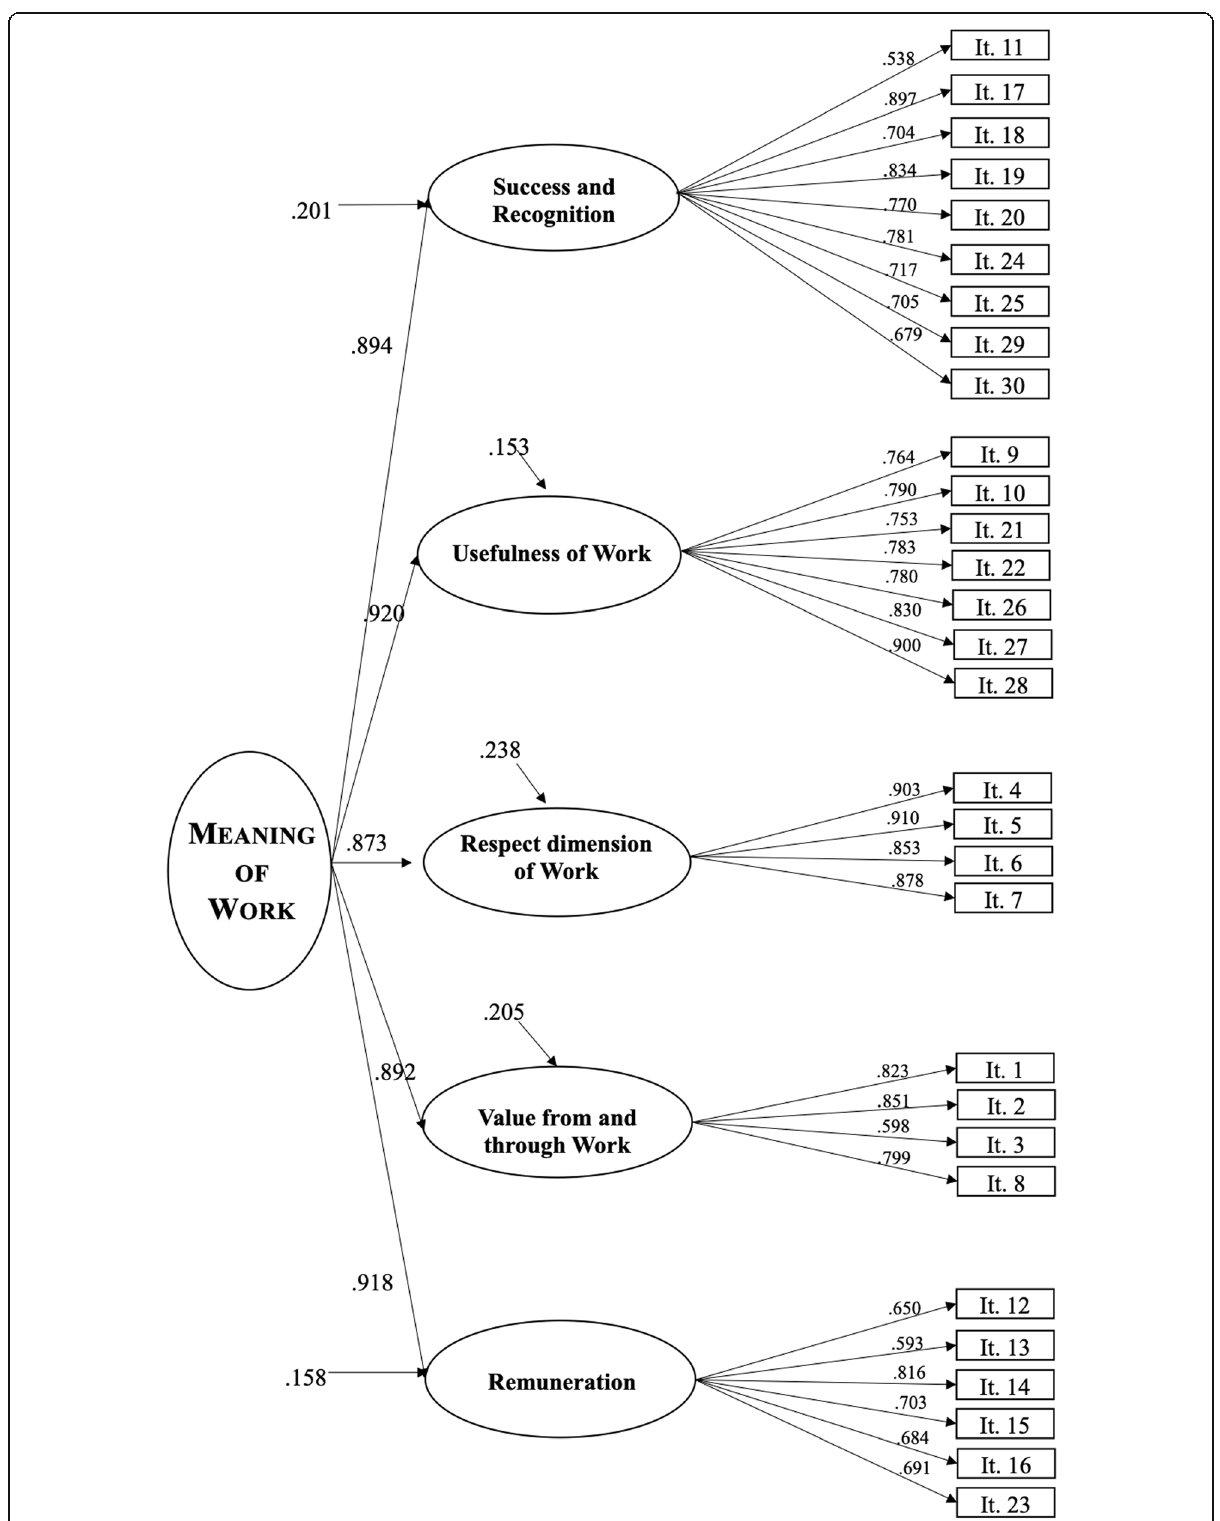
Fig. 1 Standardized solution of the structural model of the Meaning of Work